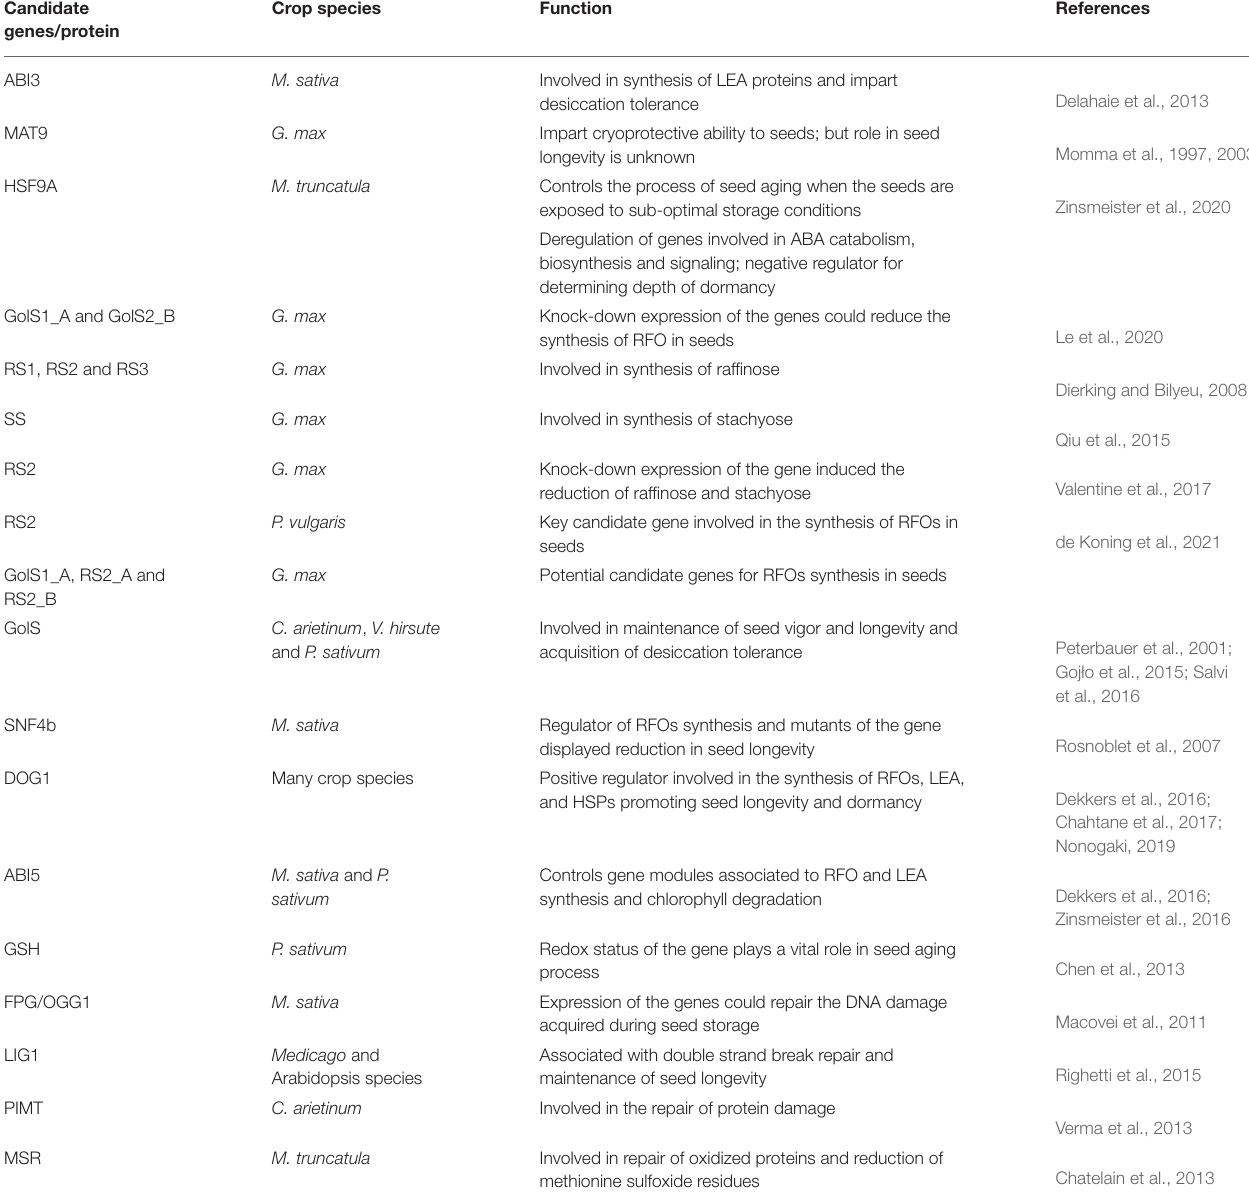
TABLE 1 | Candidate genes/proteins responsible for imparting desiccation tolerance and longevity in seeds during maturation and storage. Candidate